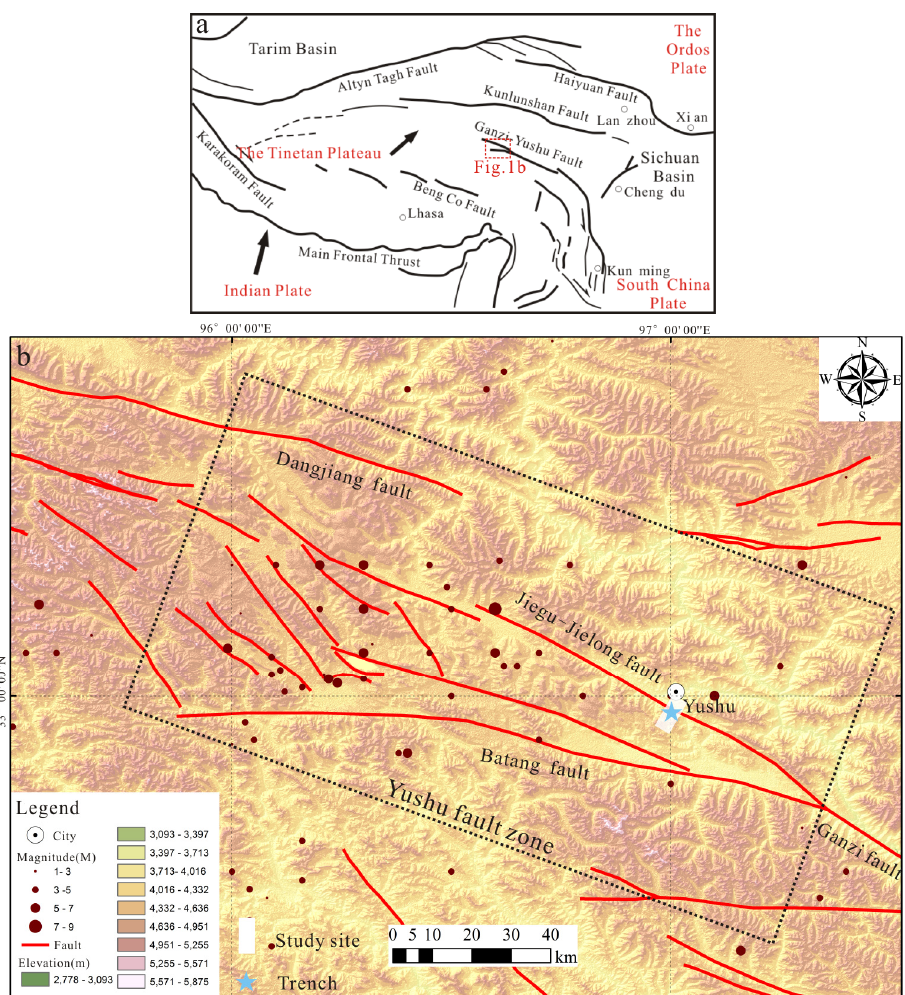
Figure 1. Location maps of the Yushu fault. ( a ) Sketch maps of active faults on the Tibetan Plateau and adjacent areas. ( b ) Topographic map of the Yushu